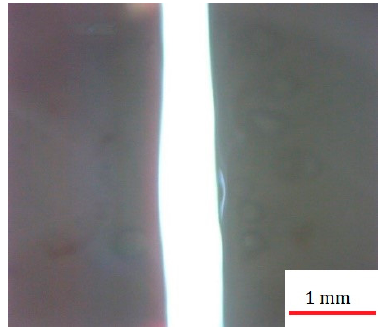
Figure 15. Image of the cut kerf of the optimized sample #5.